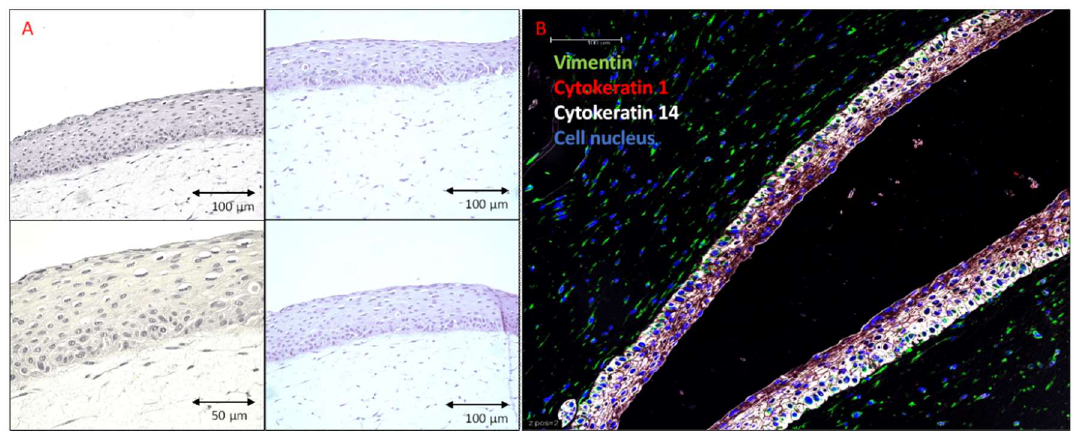
Figure 2. Human skin equivalent generated using PCS-200-010 and PCS-201-010 cell lines and differentiated for 14 days. Sections of the formalin-fixed, and paraffin-embedded, 3-dimensional (3D) skin models. ( A ) Hematoxylin and Eosin staining. HSEs consist of well-differentiated epidermis on top of a fibroblast-populated dermis. ( B ) Fluorescent immunostaining. Green—Vimentin (Biolegend 677807), Red—Cytokeratin 1 (LSBio LS-C180221), White—Cytokeratin 14 (Abcam ab77684), Blue—Cell nucleus (DAPI). Cytokeratin 14 is strongly expressed in keratinocytes forming a basal layer with lower expression in the keratinocytes of the more apical layers, stratum spinosum, and stratum granulosum. Cytokeratin 1 expression is detected in the fully differentiated epidermis.